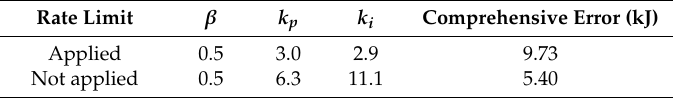
Table 4. Optimization results with and without the rate limit.